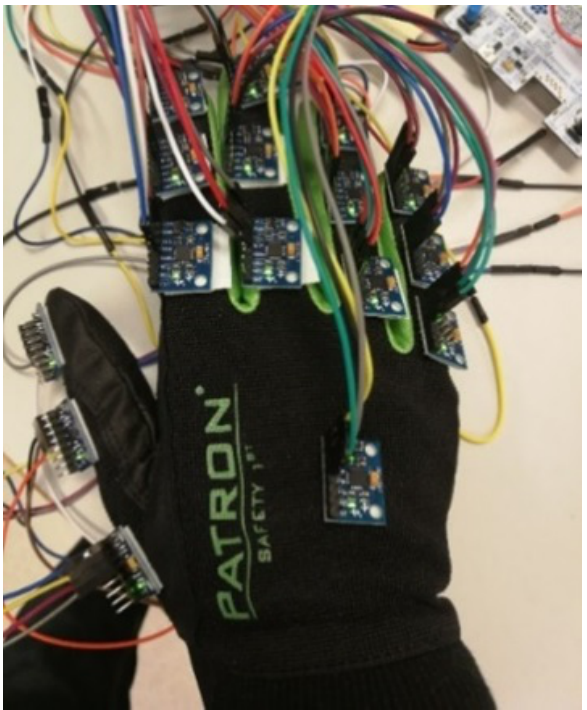
Figure 4: Glove prototype with 16